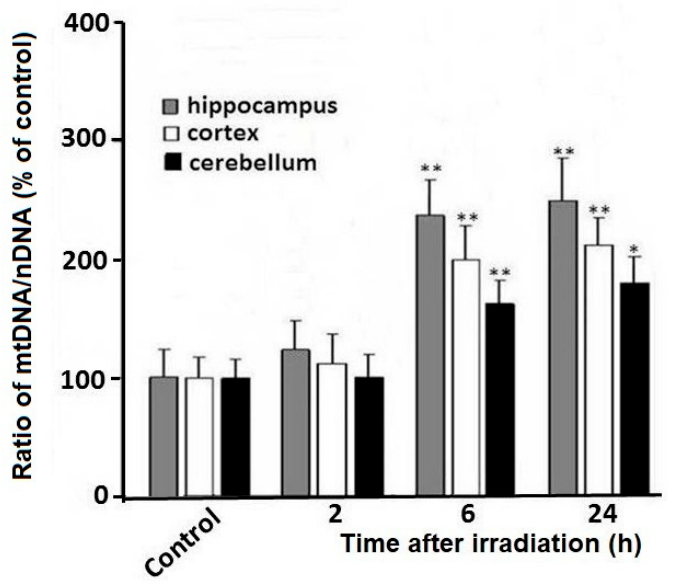
Figure 2. Ratio of mtDNA / nDNA in tissues of the rat brain after irradiation. The y-axis shows the percentage (%) of the change in a mtDNA to nDNA ratio relative to control. The data are presented as mean ± SD from 4–5 independent experiments. Statistical significance was set at * p < 0.05, ** p < 0.01.